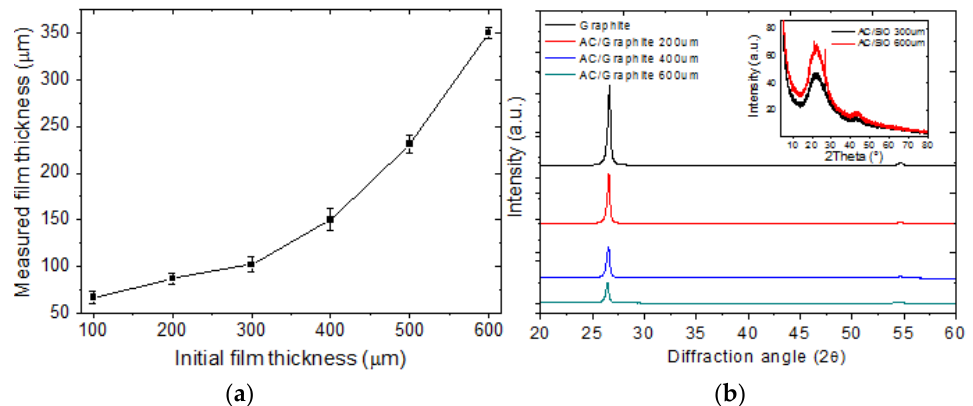
Figure 3. ( a ) Variation of measured film thickness as a function of initial film thickness. ( b ) DRX patterns for various electrode thicknesses. Table 1. Comparison between initial film thickness and measured thickness, specific capacitance and effective mass of the active material on the electrode for various electrode thicknesses.